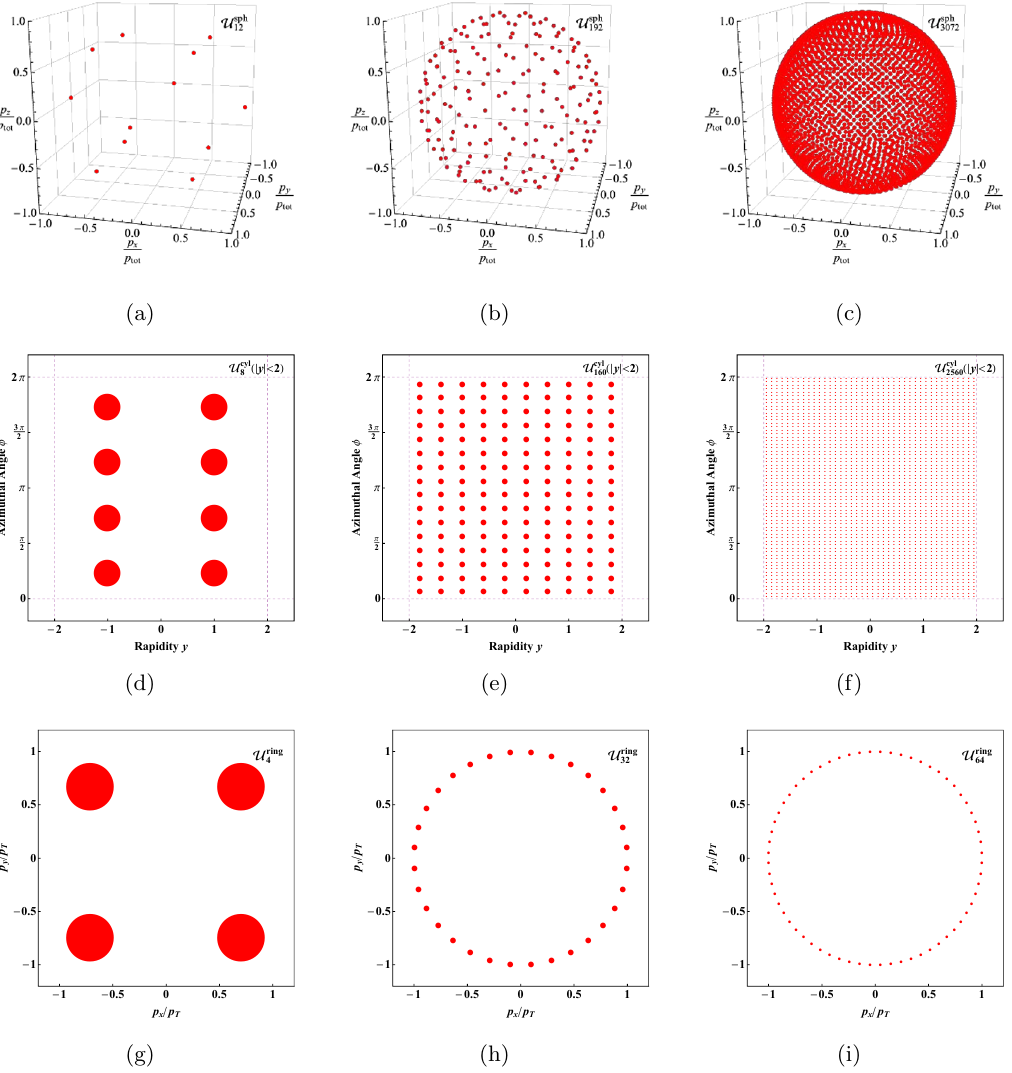
Figure 1 . Quasi-uniform event con(cid:12)gurations for the three geometries considered in this paper. Top row (a,b,c): spherical con(cid:12)gurations U sph for n = f 12 ; 192 ; 3072 g , generated with HEALPix . n Middle row (d,e,f): cylindrical con(cid:12)gurations U cyl for n = f 8 ; 160 ; 2560 g . Bottom row (g,h,i): ring n con(cid:12)gurations U ring for n = f 4 ; 32 ; 64 g . All particles have equal weights. The middle column n corresponds to our default uniform con(cid:12)gurations for each geometry.